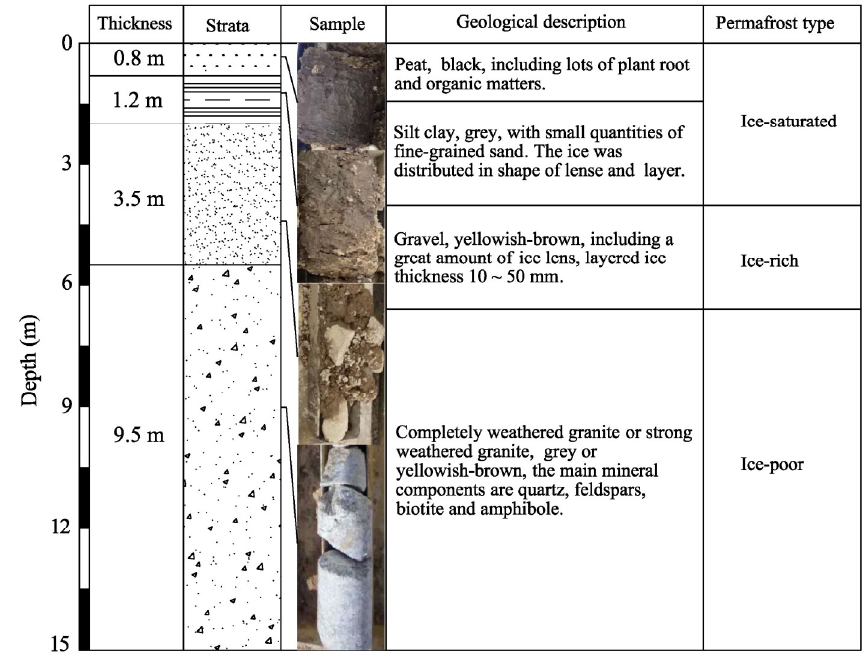
Figure 5. Geological characteristics of the MDS304 site, 0–15 m [42].